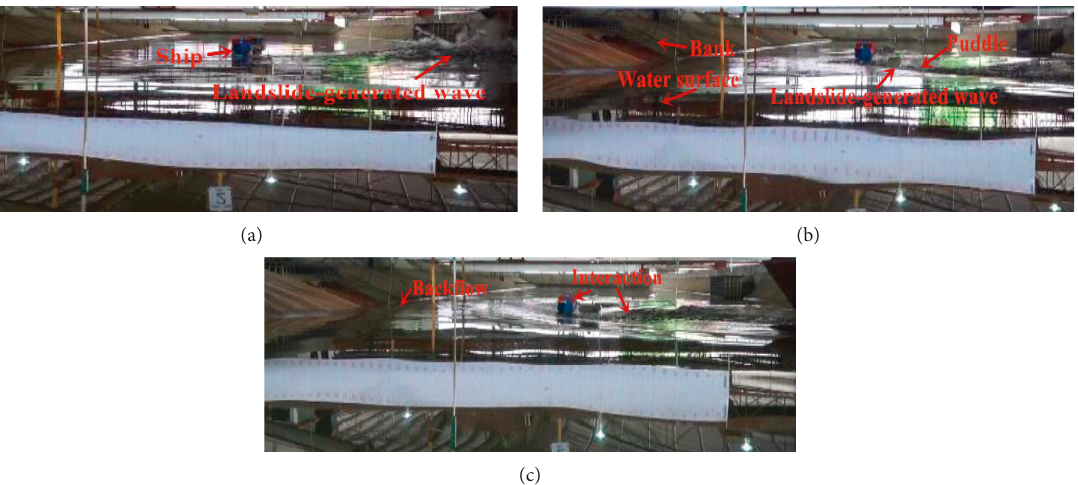
Figure 8: Main stages of interaction between a ship and a landslide-generated wave. (a) The formation of a landslide-generated wave; (b) the propagation of a landslide-generated wave; (c) the interaction between a ship and a landslide-generated wave.